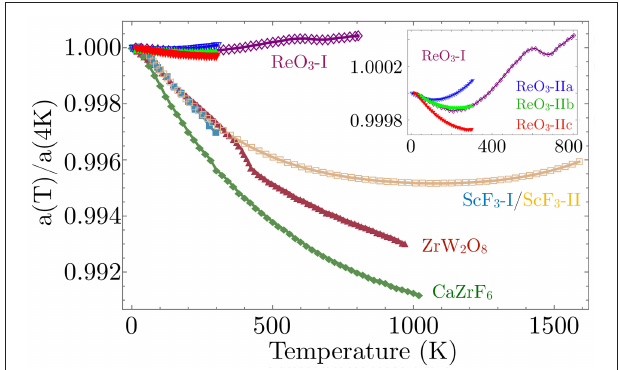
FIGURE 5 | Shown here is the normalized cubic lattice parameter temperature dependence a ( T ) / a (4 K ) for ReO 3 , ScF 3 , and CaZrF 6 NTE perovskites with strong SNTE material ZrW 2 O 8 for comparison. Inset focuses on available data for ReO 3 on 4 different samples, one (ReO 3 -I) over an extended temperature range (Chatterji et al., 2009b) and the other 3 (ReO 3 -II a-c) over a smaller temperature range, investigating the effects of compositional disorder ( Rodriguez et al., 2009) (see section 5). Data taken from: ZrW 2 O 8 (Mary et al., 1996 ), CaZrF 6 (Hancock et al., 2015), ScF 3 -I (Handunkanda et al., 2015), ScF 3 -II ( Greve et al., 2010), ReO 3 -I (Chatterji et al., 2009b), and ReO 3 -II (Rodriguez et al.,